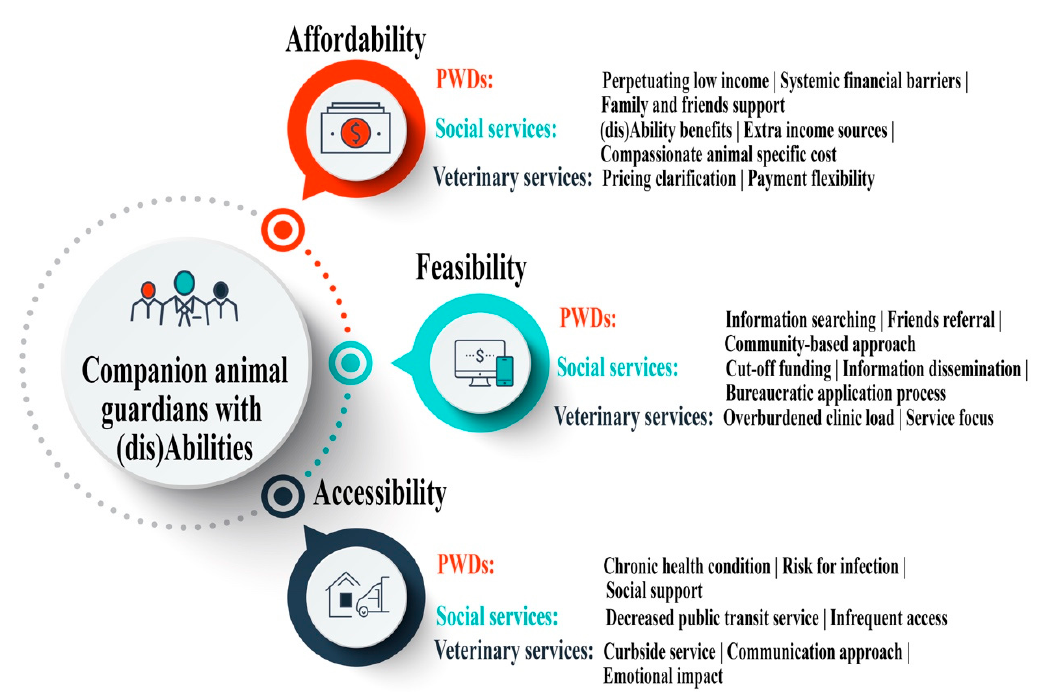
Figure 1. Themes and codes. The three circles (Affordability, Feasibility, and Accessibility) demonstrate the three themes that emerged in the data analysis regarding PWDs’ access to veterinary services during the first lockdown of COVID ‐ 19. Under each theme, tri ‐ level sub ‐ categories were developed to provide detailed supportive information, namely PWD (RED), social service (GREEN), and veterinary service (NAVY). Each subtheme was followed by different codes, which were used to identify related information from interview transcripts.